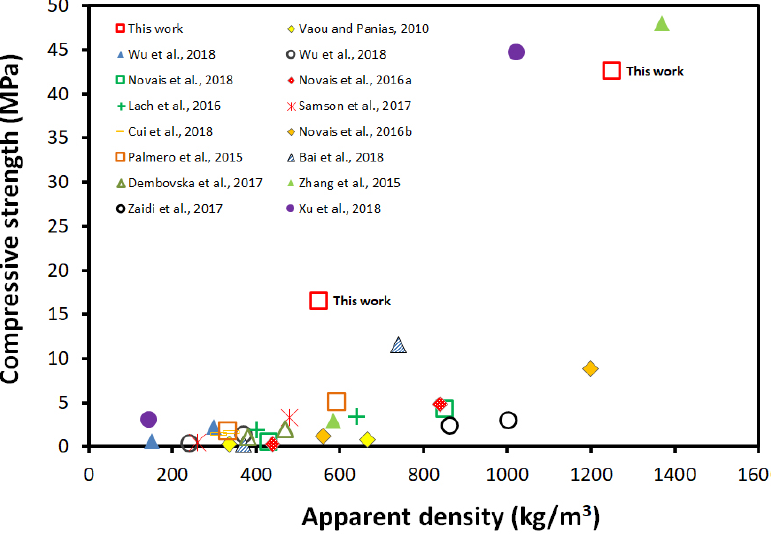
Figure 4. Review and literature comparison concerning compressive strength versus apparent density in lightweight geopolymer [8,11,12,14,15,26,28,29,30,31,32,33,34].